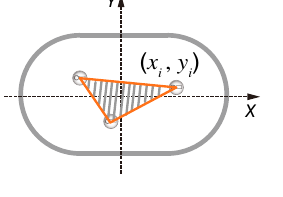
FIG. 9. Definition of the shape indices S